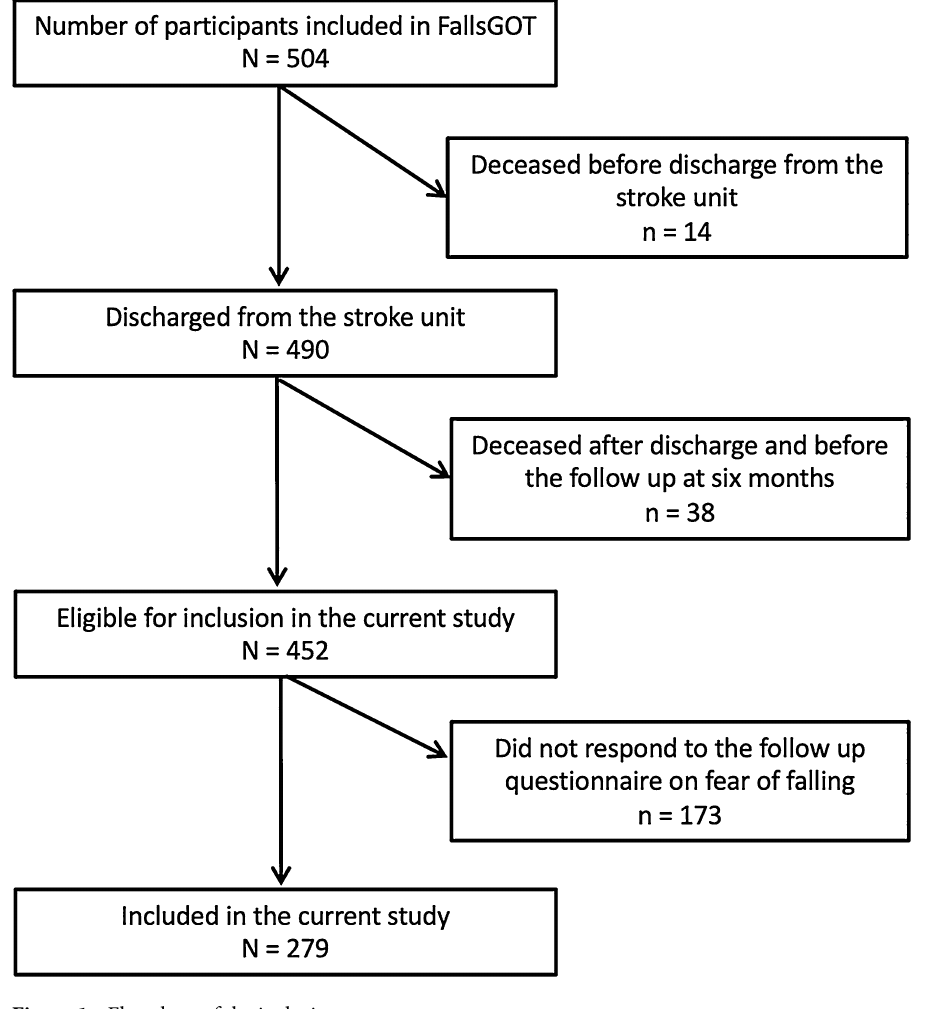
Figure 1. Flowchart of the inclusion